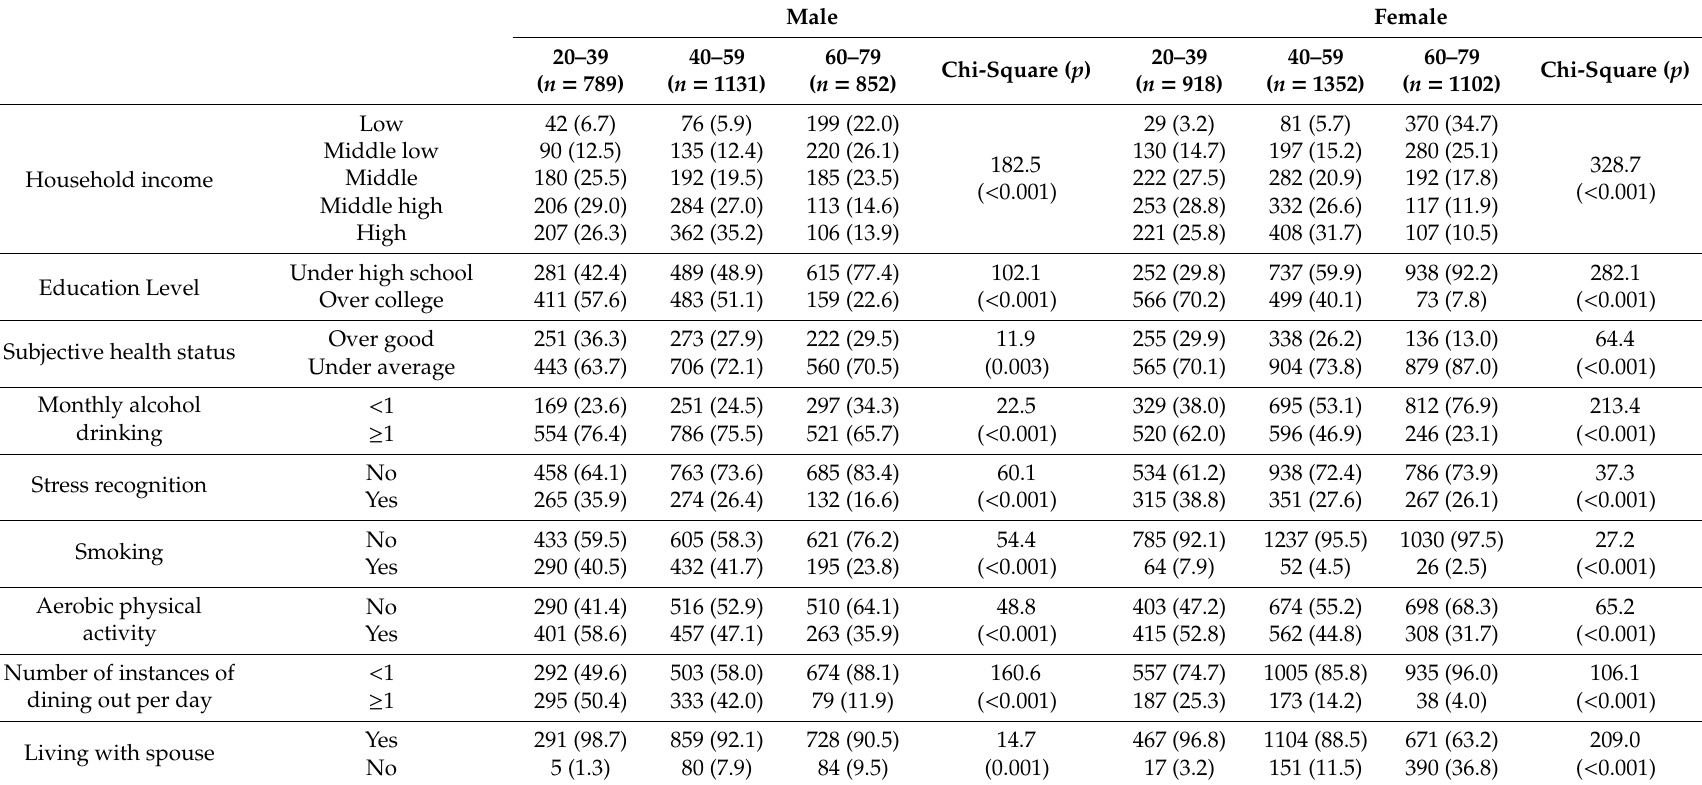
Table 1. General characteristics of subjects by sex and age groups ( n ,